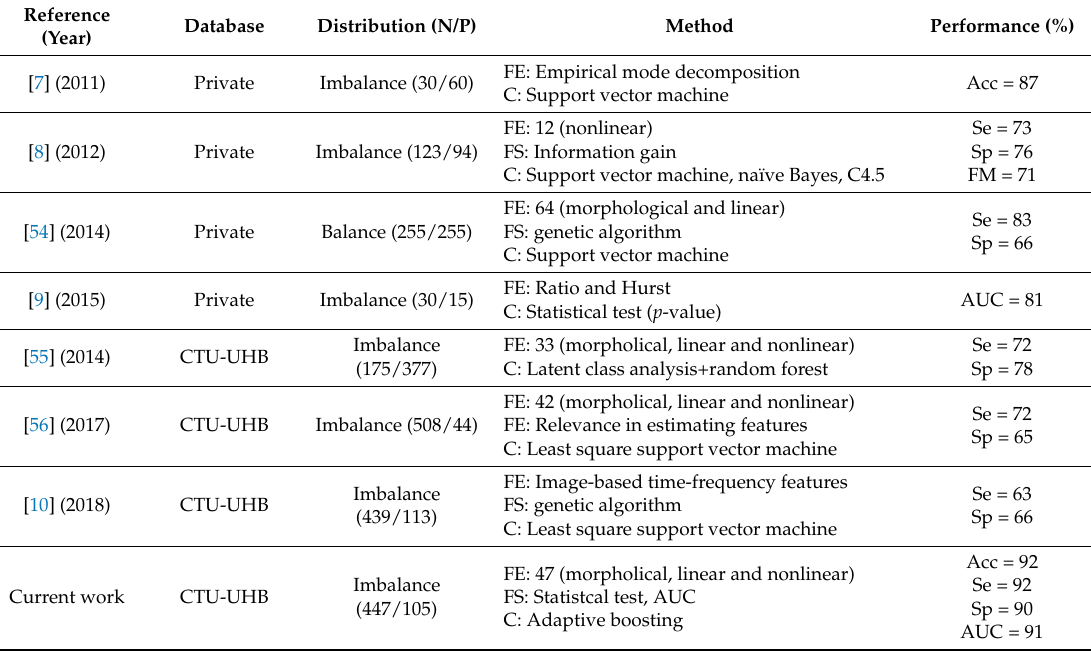
Table 5. Summary of recent work on the discrimination of fetal pathological conditions using FHR signals. (N = normal, P = pathological, FE = feature extraction, FE: Feture selection, C: